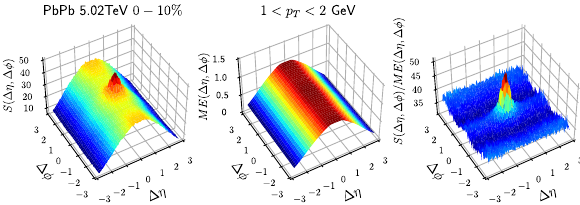
Fig. 1 Jet-particle correlations using charged particles with 1 < p T < 2 GeV in central 0 − 10% Pb + Pb collisions. The left panel is for signal pair distribution S ((cid:2)η,(cid:2)φ) , the middle for normalized mixed-event pair distribution ME ((cid:2)η,(cid:2)φ) , and the right for acceptance-corrected per-trigger-jet associated particle